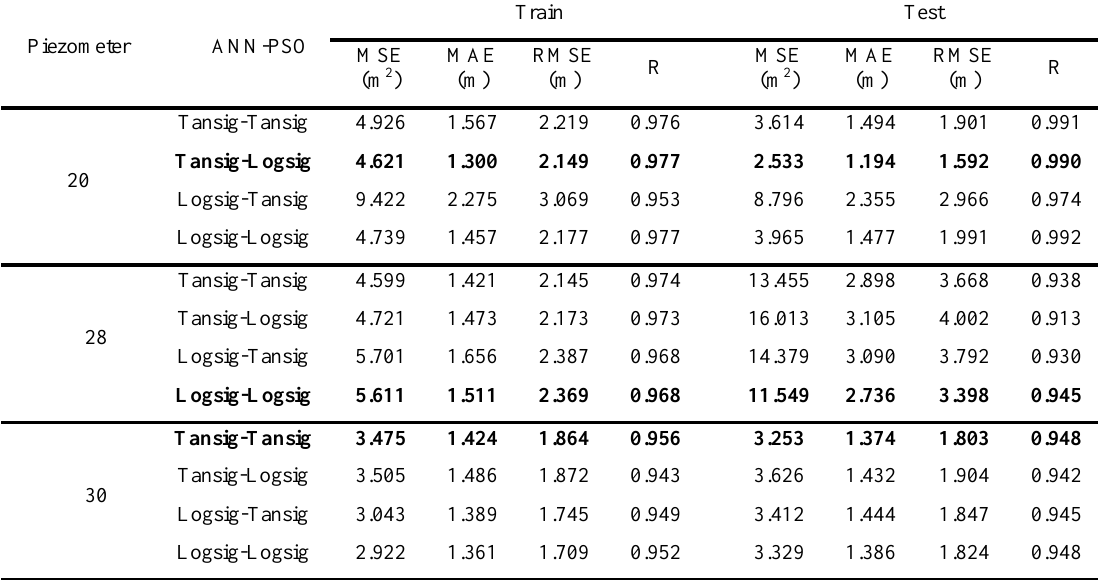
Table 4- Results of combining ANN-PSO in order to simulate water level variations of piezometers of Jiroft Dam Piezometer